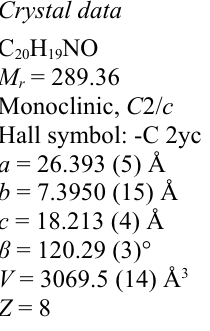
Figure 1 The molecular structure of the title compound with displacement ellipsoids shown at 30% probability for non-H atoms. (Anthracen-9-yl)(piperidin-1-yl)methanone Crystal